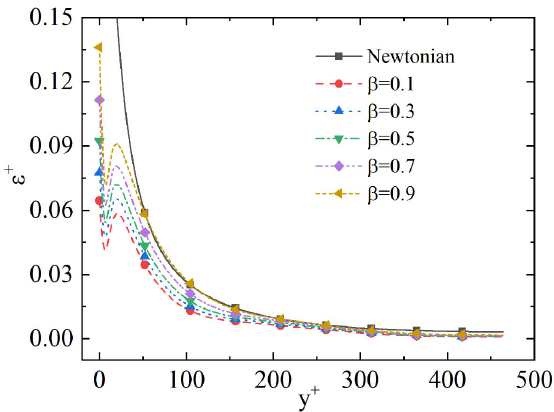
Figure 21. Dimensionless turbulent dissipation rate ( ε + ) of different solvent viscosity ratios ( β